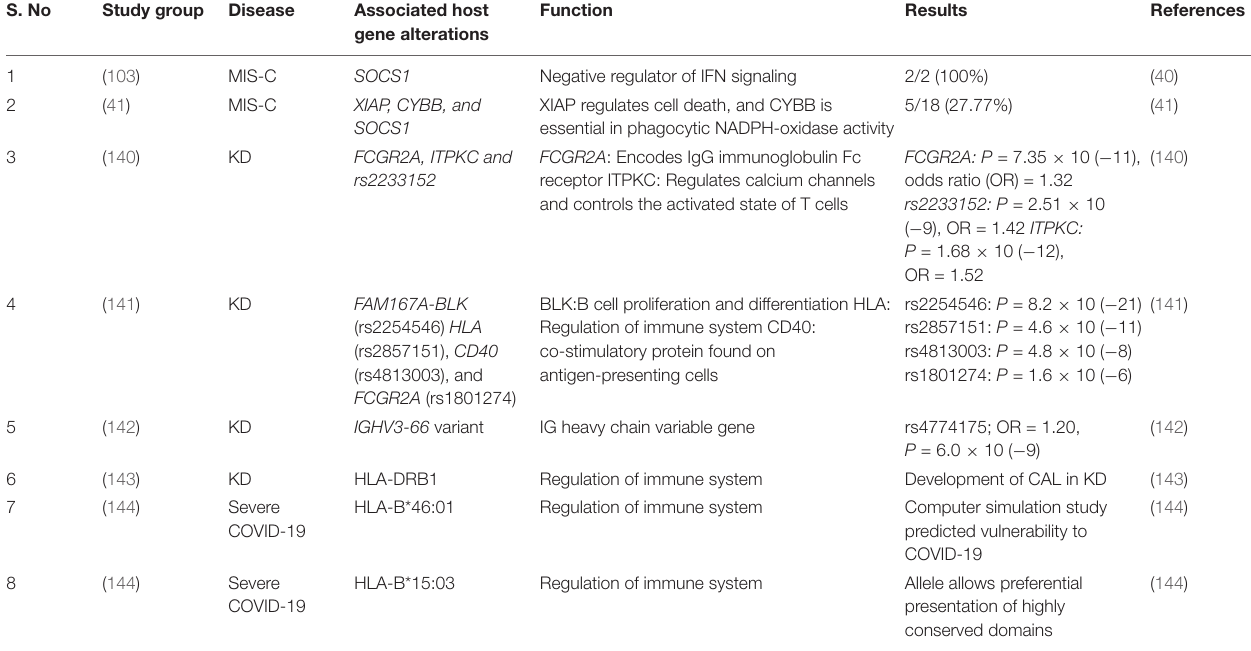
TABLE 3 | Genetic loci associated with KD, MIS-C and severe COVID-19. S. No